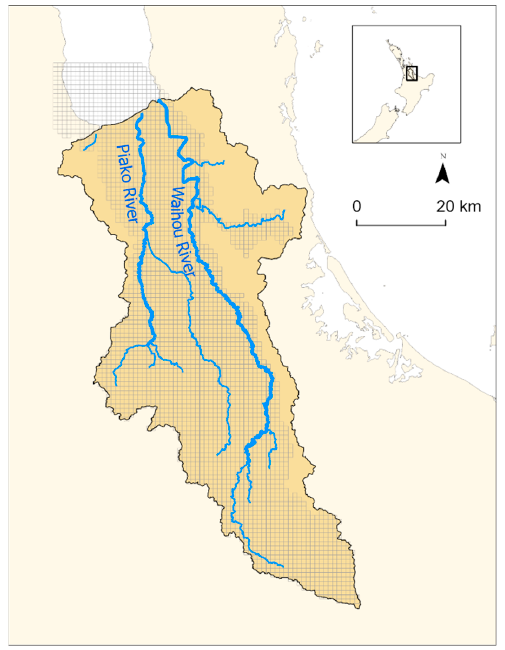
Figure 3. Location of the Hauraki case study. Grey grid lines show MODFLOW groundwater model cells. The MODFLOW domain only covers a part of the case study area. The blue lines show the main rivers and tributaries.